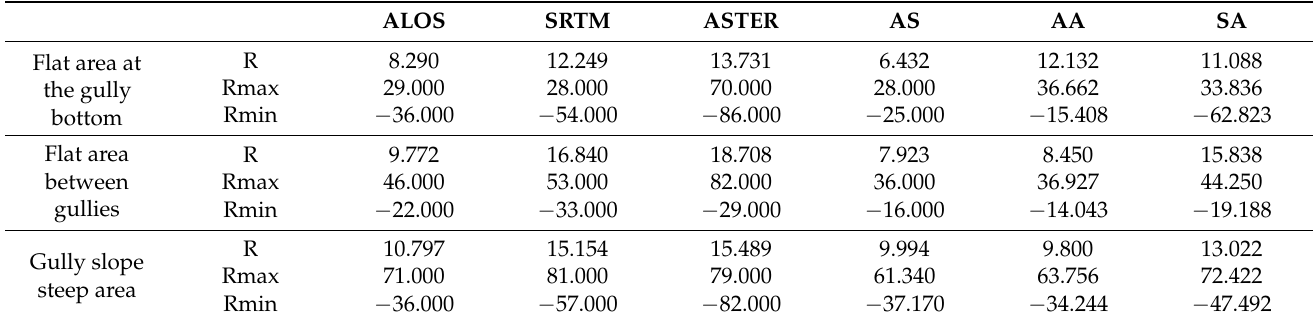
Table 11. The error statistical value of partition weighted fusion in Suide (unit: m). ALOS SRTM ASTER AS AA